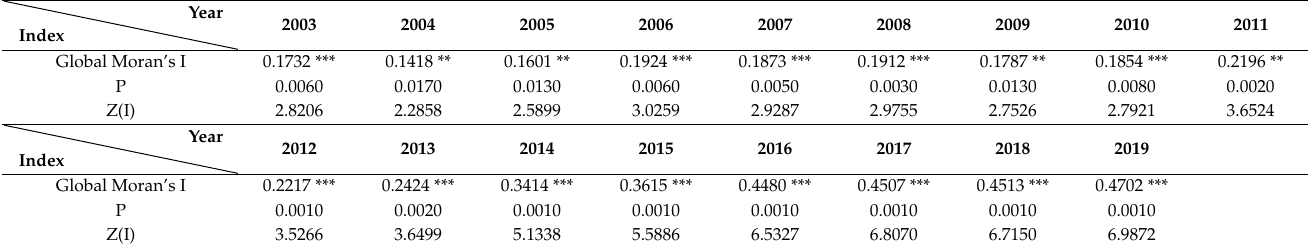
Table 2. ULUE Global Moran’s I index of the Yangtze River Economic Zone from 2003 to